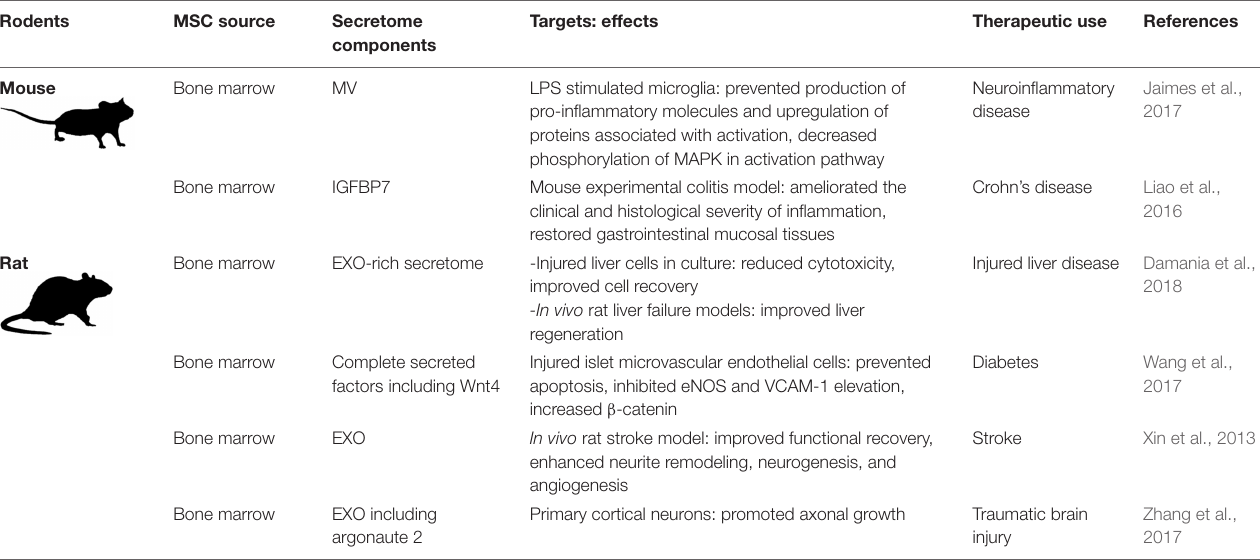
TABLE 2 | Rodent MSC secretome components, targets, effects, and potential therapeutic uses.